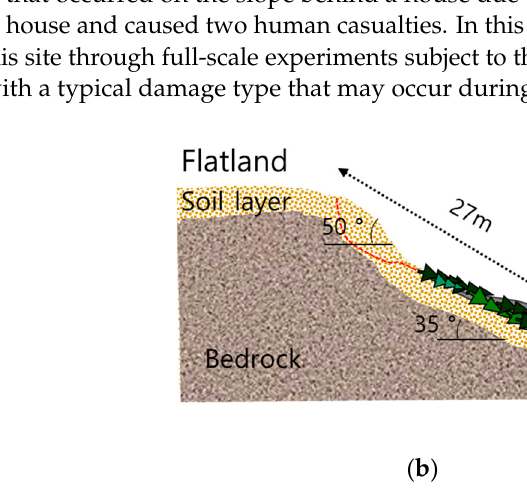
Figure 11. Shallow failure site and failure section: ( a ) field; ( b ) description.